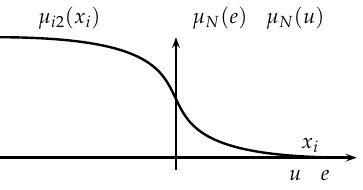
Figure 11. Membership function to model negative values.